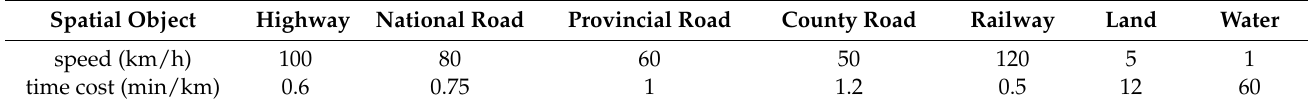
Table 1. Time cost of different spatial